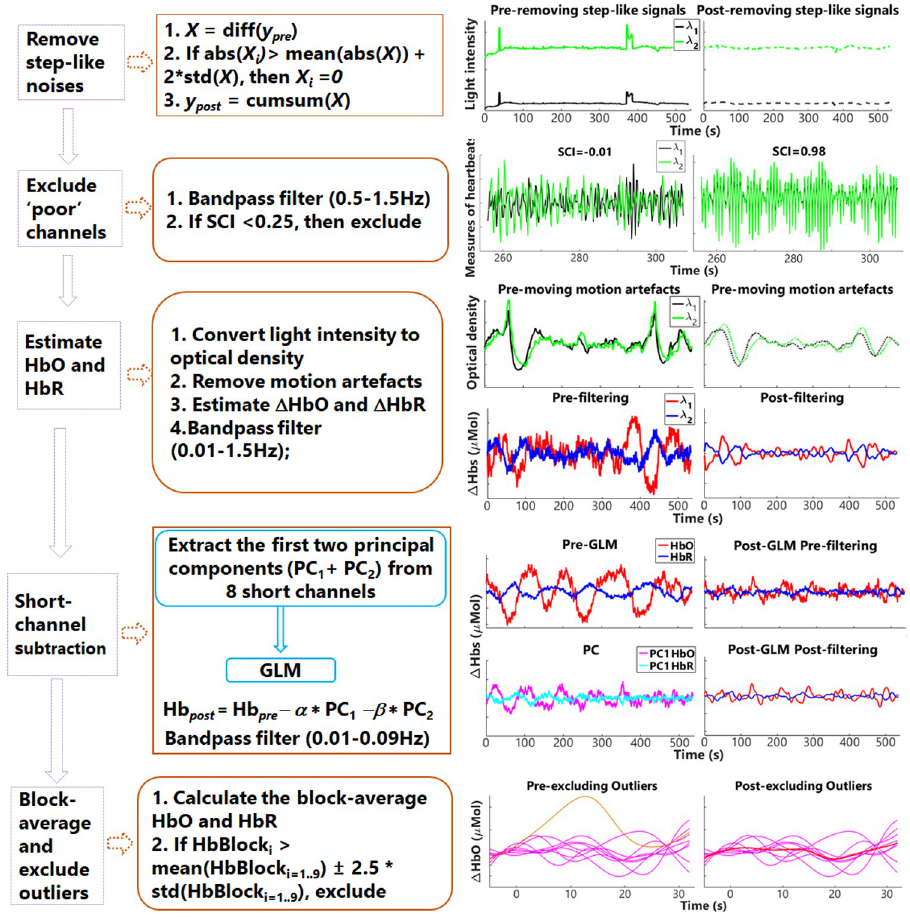
Fig 3. Diagram of fNIRS signal